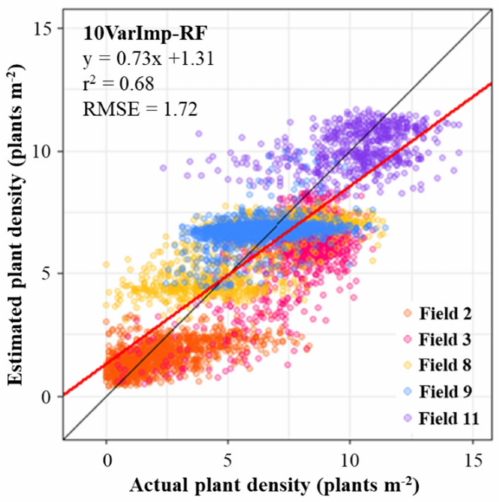
Figure 8. Variable importance ( IncNodePurity values) list of the full random forest regression model (SR + NDVI + Climate).